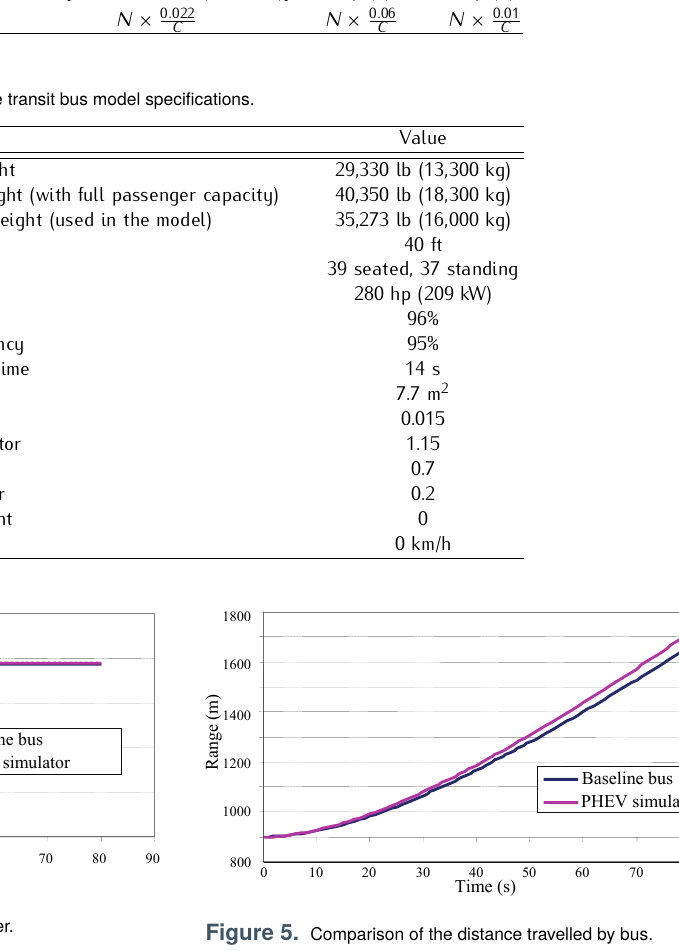
Figure 5. Comparison of the distance travelled by bus.